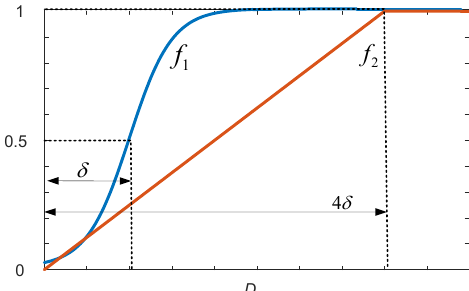
Figure 2. Example designs of cumulative distribution functions (CDFs), mapping the resource experience D of an agent to a collision probability on certain resource. f 1 : sigmoid-based CDF for important (sensitive) resources. f 2 : linear CDF for trivial (insensitive) resource. δ : offset parameter adjusting the tolerance level